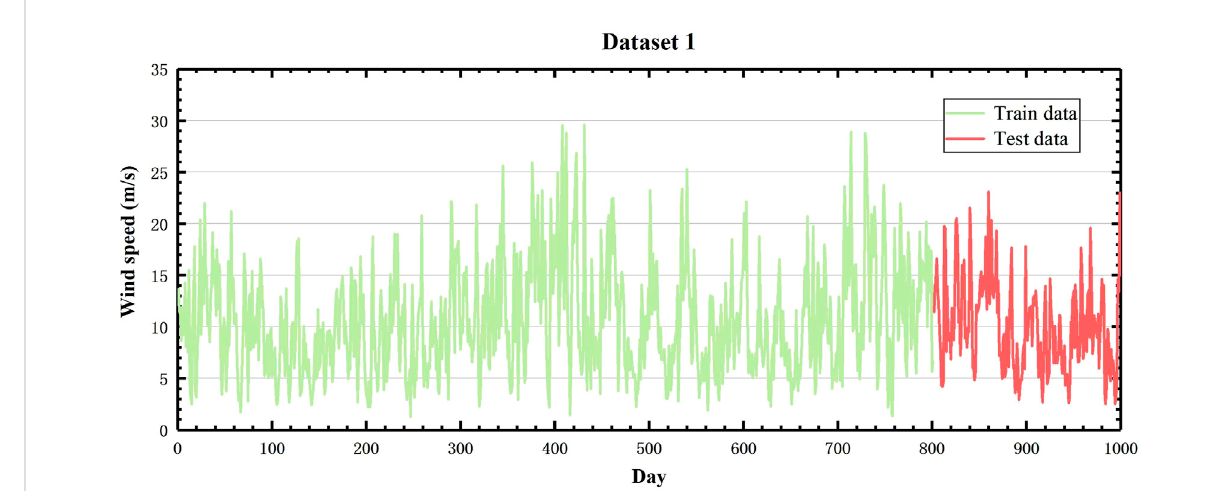
FIGURE 2 Original wind speed dataset 1.